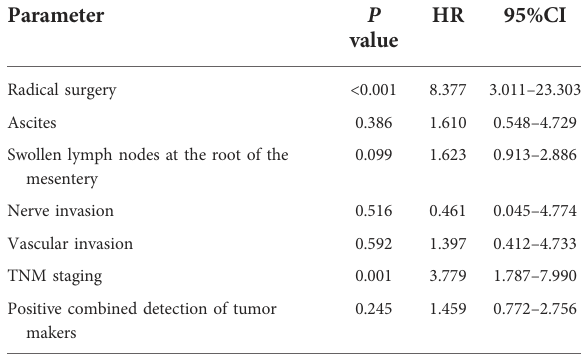
TABLE 5 Spearman rank correlation test for tumor makers of patients with colon cancer.